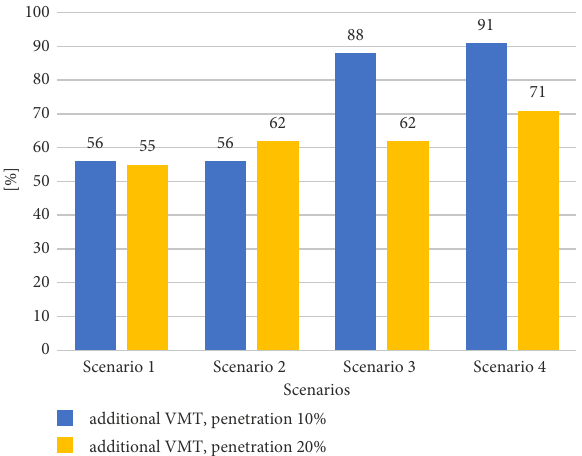
Figure 7. VMT differences across the two AVs penetrations